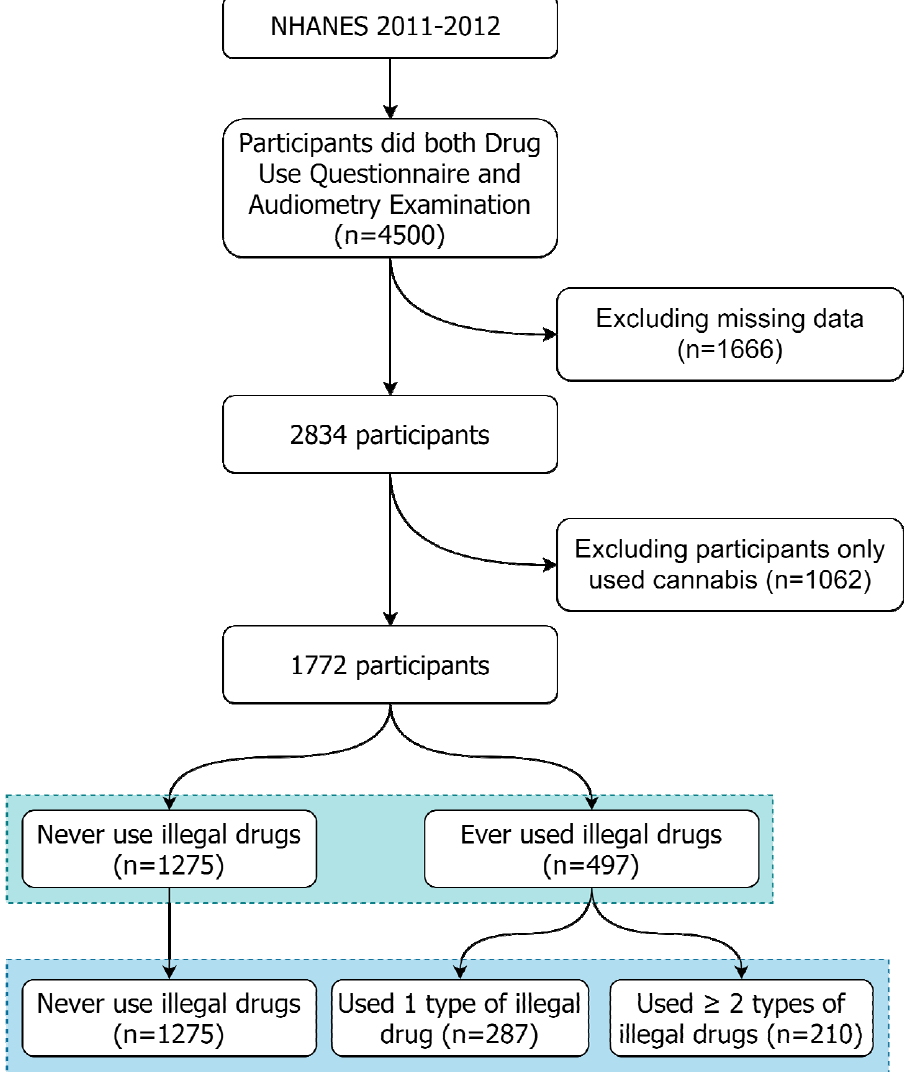
Figure 1. Flow diagram for the selection of sampled patients.